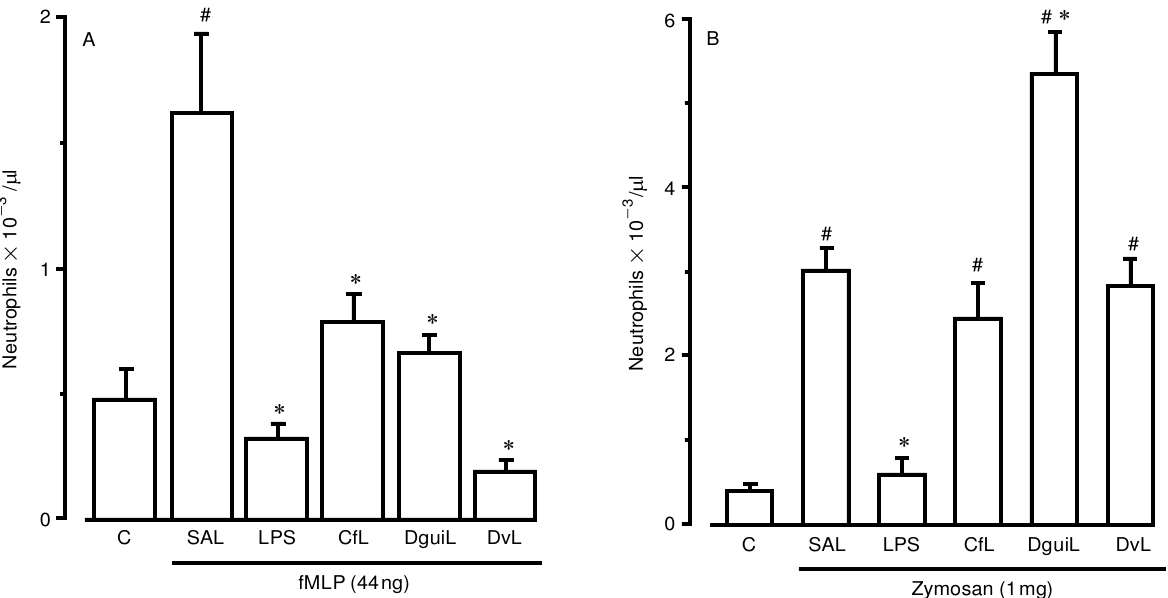
FIG. 2. Effect of i.v. injection of E. coli endotoxin (LPS) and lectins from Cratylia ¯ oribunda (CfL), D. guianensis (DguiL) and D. violacea (DvL) seeds on neutrophil migration into the peritoneal cavity in rats injected with fMLP (44 ng, A) or zymosan (1 mg, B). The lectins (1 mg / kg, i.v.) and LPS (30 m g / kg) were administered 30 min before the in¯ ammatory stimulus. In® ltrates for cell counts were collected 4 h after fMLP or zymosan injections. Control animals (C) received saline (0 · 1 ml / 100 g) both by i.v. and i.p. routes. SAL refers to animals that received saline i.v. and Cg i.p. Values are mean SEM for the number of animals used (n = 5 - 12).